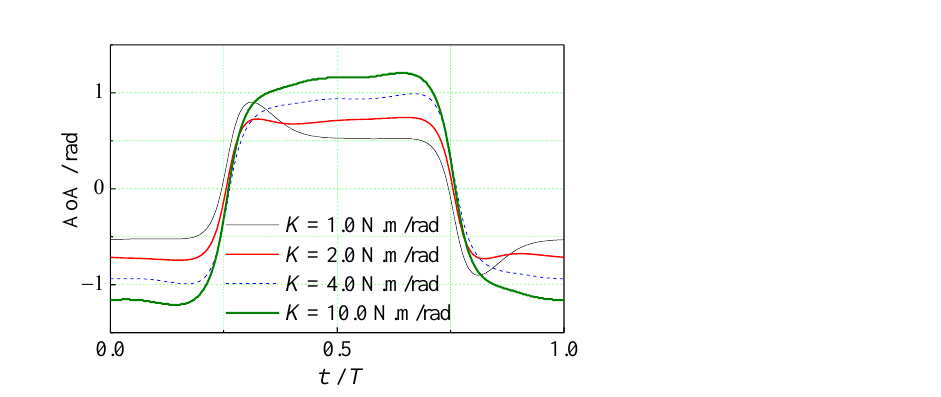
Figure 10. AoA time-history curve of the flapping foil with different spring stiffness for L/c = 5.0, J = 0.67.